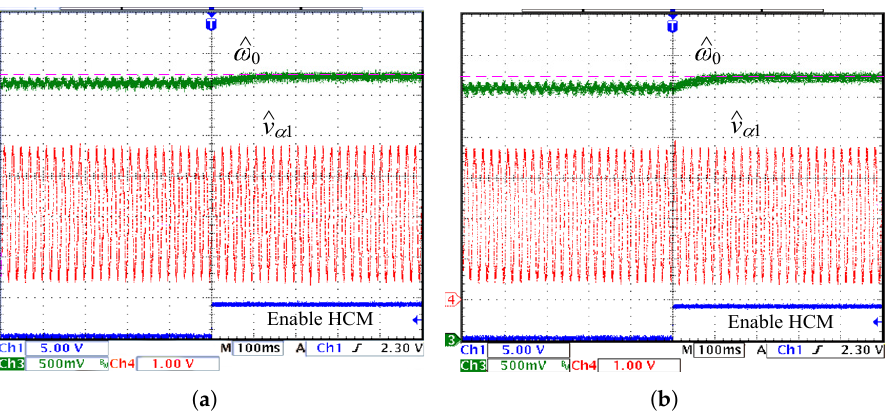
Figure 11. Transient response after enabling the HCM for f 0 = 50 Hz for ( a ) the proposed SOHO-based FLL, and ( b ) SOGI-based FLL. (top) ˆ ω 0 (y-axis: 48.83 rad/s/div), (middle) ˆ v α ,1 ( y -axis: 200 V/div) and (bottom) HCM enable signal ( x -axis: 100 ms/div in all